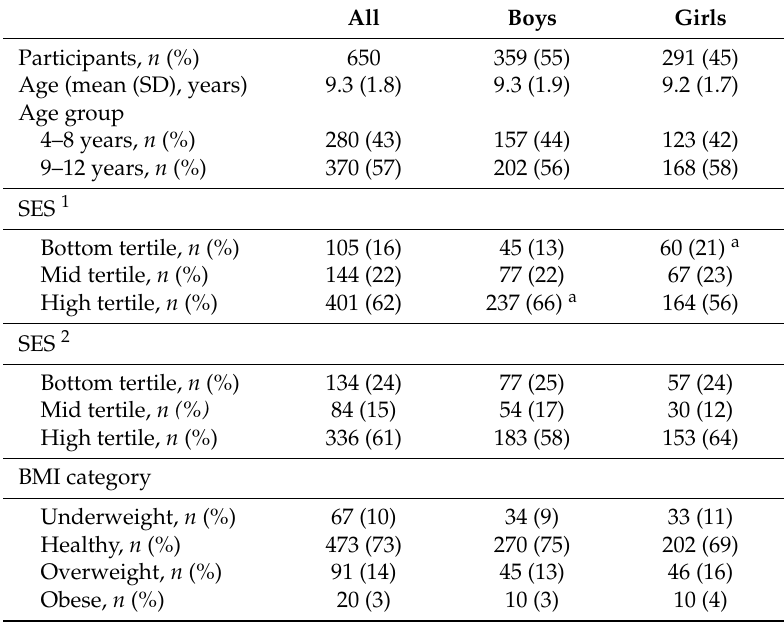
Table 1. Descriptive characteristics of participants—mean (SD) or n (%).